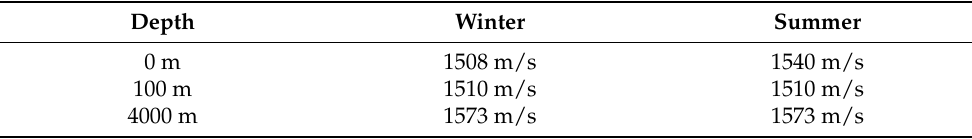
Table 2. Piecewise linear sound-velocity